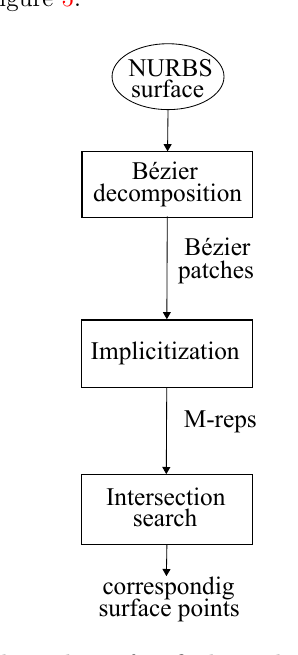
Figure 5: Flow chart for finding the corresponding body surface point on Ω c